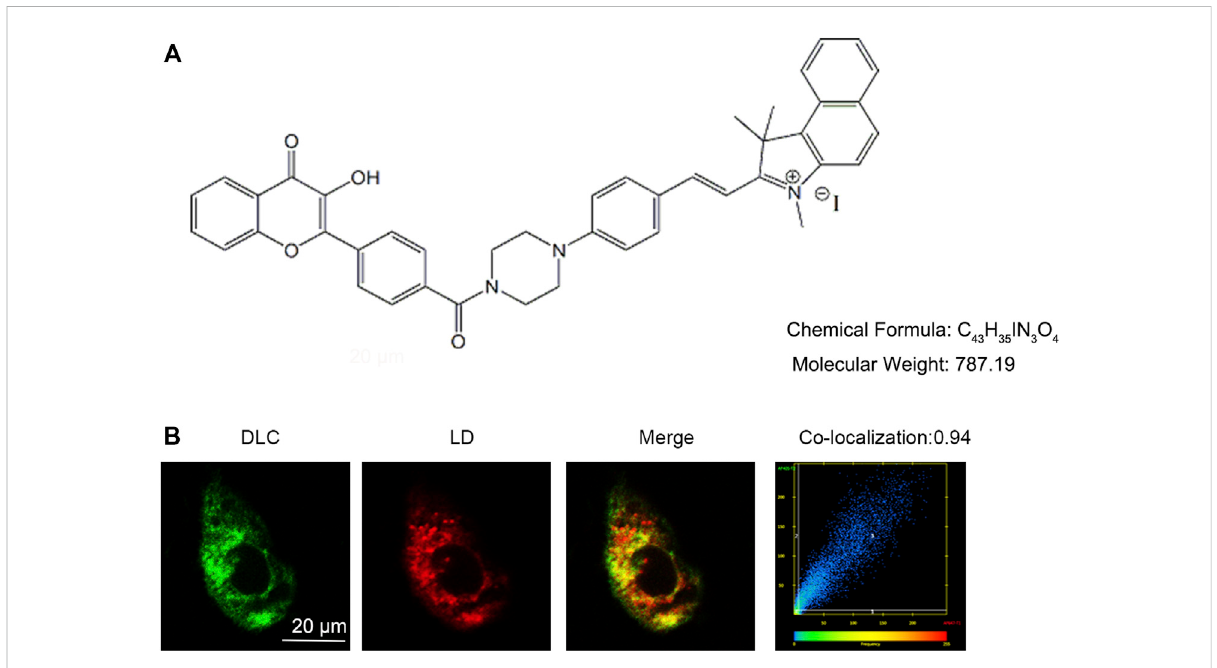
FIGURE 1 DLC co-localized with lipid droplets. (A) The chemical structure of DLC. (B) HUVECswere treated with 1 μ M DLC for 12 h and stained with HCS Lipid TOX ™ Deep Red neutral lipid stain. Co-localization coef fi cient of DLC and LDs was 0.94 in HUVECs. Scale bar, 20 μ